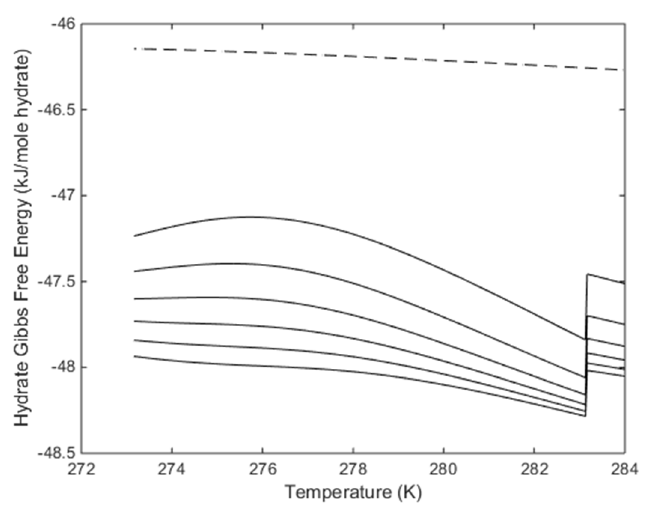
Figure 14. Calculated Free Energies for hydrate formed along stability limits in pressure and temperature stability limits as plotted in Figure 13. Lowest solid curve is for 30 mole per cent CO 2 , followed by 25 mole per cent CO 2 , then 20 mole per cent CO 2 , then 15 mole per cent CO 2 , then 10 mole per cent CO 2 and upper solid curve for 5 mole per cent CO 2 . Dashed curve is free energy for CH 4 hydrate formed along the CH 4 hydrate stability limits in the temperature pressure projection of the stability limits.